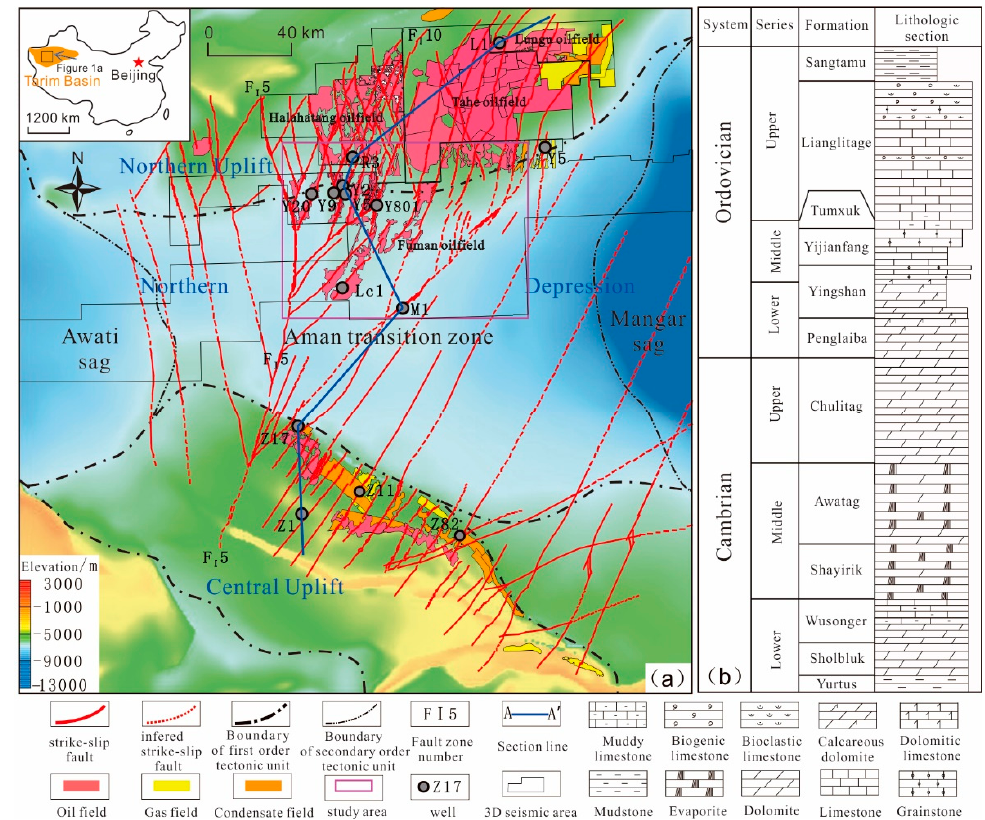
Figure 1. ( a ) The strike-slip fault system in the Ordovician carbonates (the figure at the top left corner shows the location of Figure 1a in the Tarim Basin) and ( b ) the Cambrian-Ordovician stratigraphic column in the Tarim Basin (The strike-slip fault zones are mapped by 3D seismic data, and the color base map shows the topography of the top of the Ordovician carbonate; the oil/gas distribution and tectonic sketch appear as in Reference [26]).